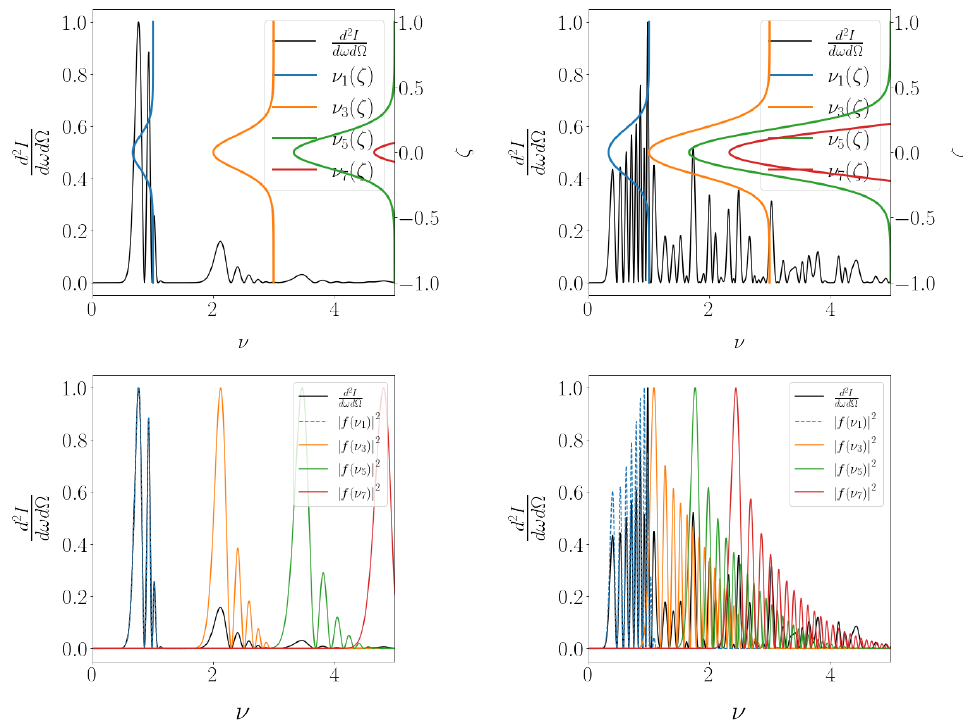
Figure 2. ( Top left ): On-axis back-scattered radiation in black for a 0 = 1 and N c = 5. Colored lines give the frequency emitted as a function of ζ for the harmonics. The harmonics are sepa- 2 + 2 + . . . and there is no dependence of φ f ν f ν rated, therefore the spectrum can be read as cep . 3 | 1 | | | ( Bottom left ): same as top left, but with the harmonics calculated separately according to Equation (5) and individually normalized to 1 for better visualization. ( Top right ): On-axis back-scattered radi- ation for a 0 = 2 and N c = 5 along with the frequency emitted as function of ζ for the harmonics. The first and third harmonics start to overlap as given by Equation (7). The higher harmonics overlap substantially. The growth of the intensity of ν 1 is clearly a consequence of the number of times ≥ a frequency is emitted, originating from different harmonic orders. ( Bottom right ): same as top right, but with the harmonics given analytically by Equation (5) and individually normalized to 1 for better visualization.